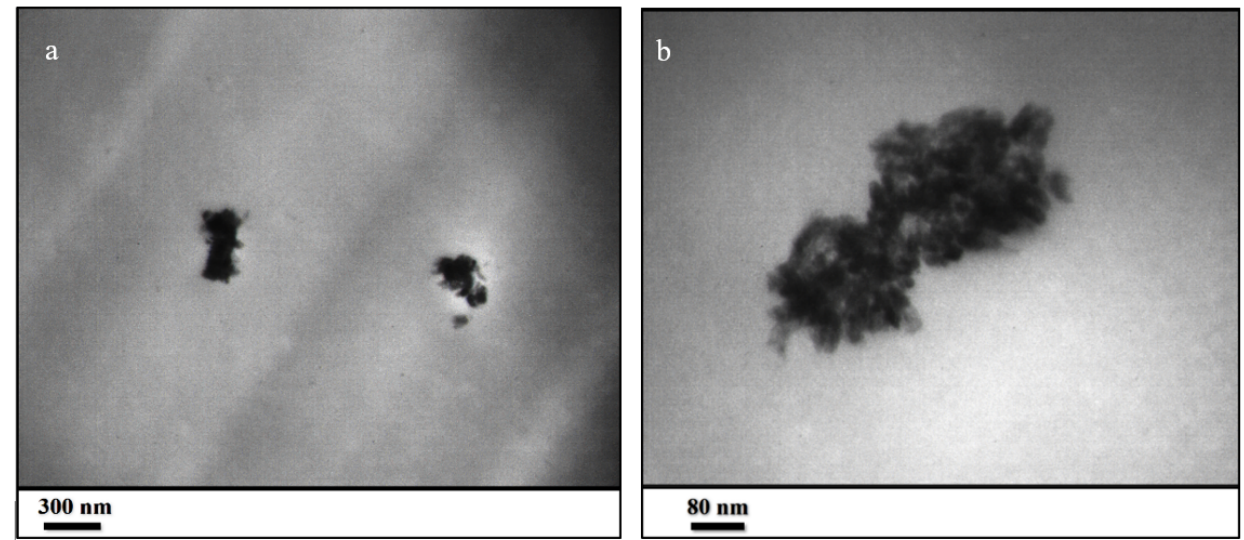
Figure 7. TEM images at low ( a ) and high ( b ) magnifications taken from the thin slice of the ZHS- containing epoxy resin prepared by the ultramicrotomy.